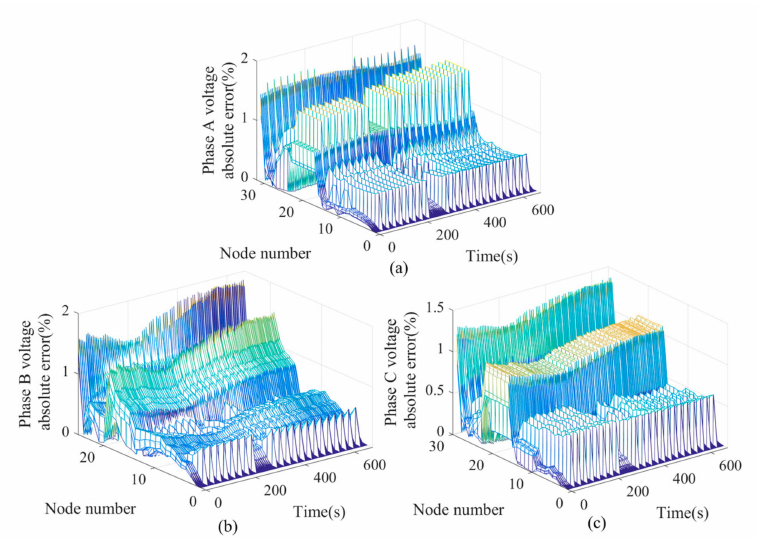
Figure 14. Three-phase voltage dynamic simulation using the original